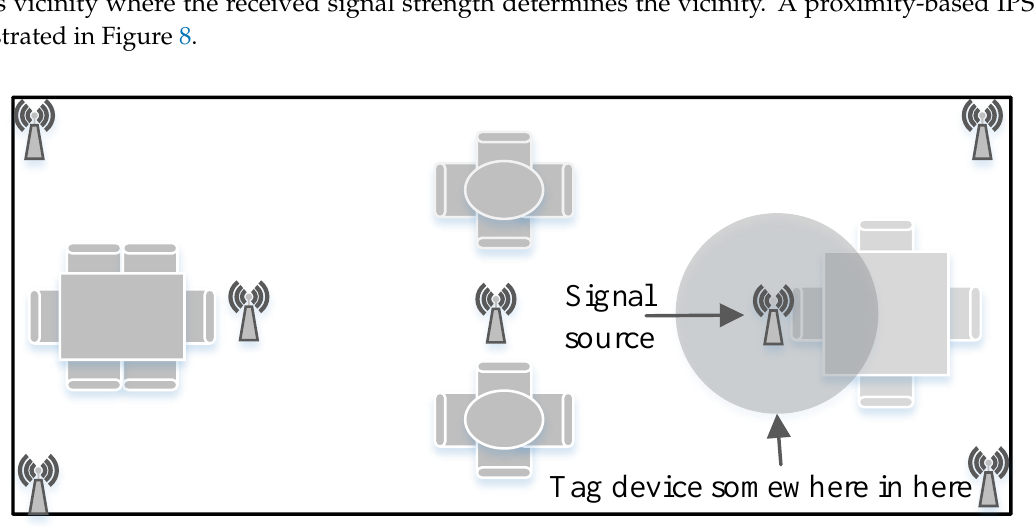
Figure 8. Graphical representation of proximity-based